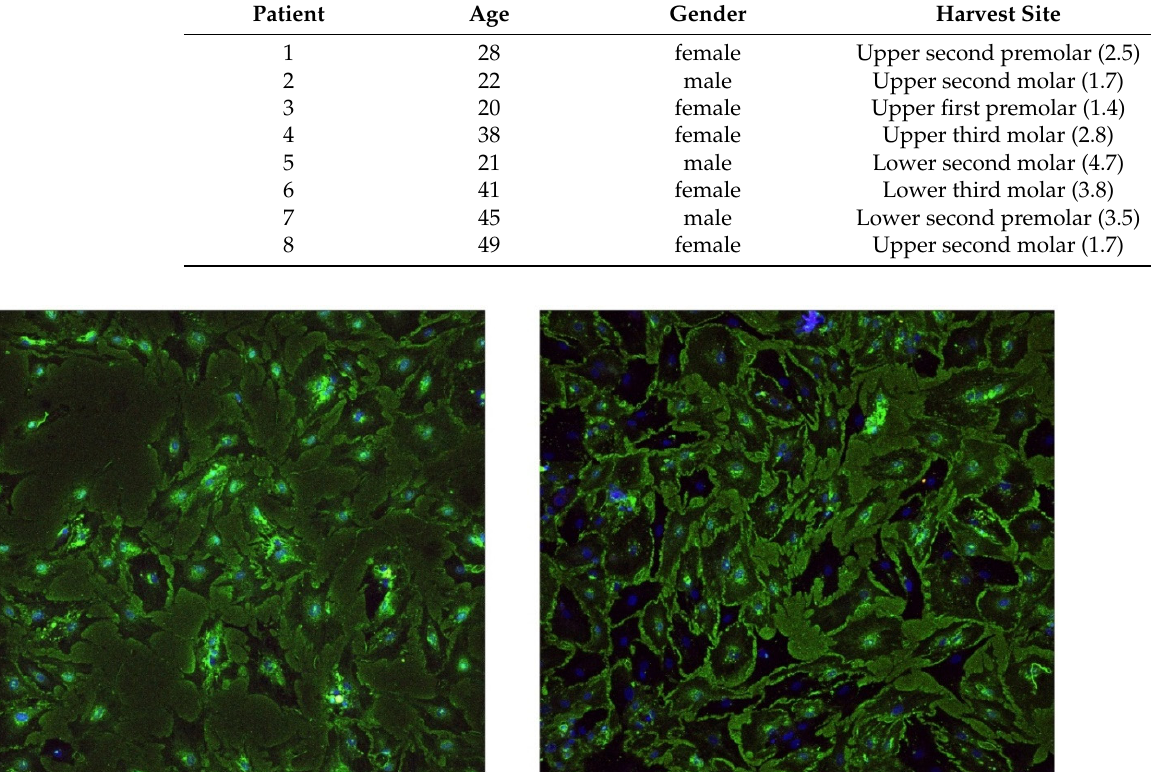
Table 3. Characteristics of the study group.